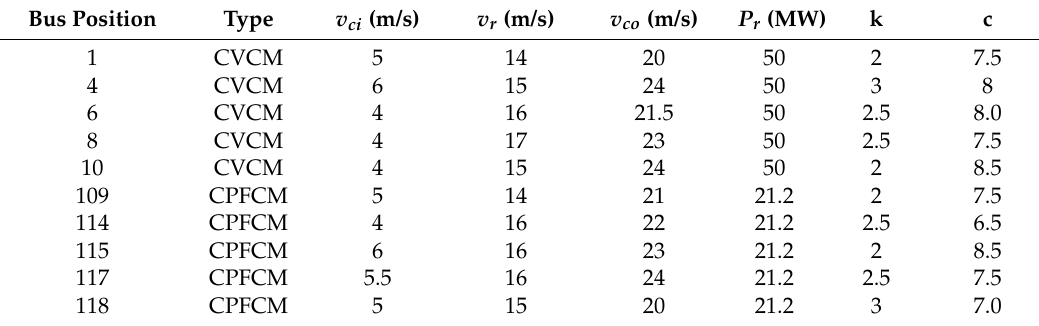
Figure 12. Bus angle results obtained by different methods.